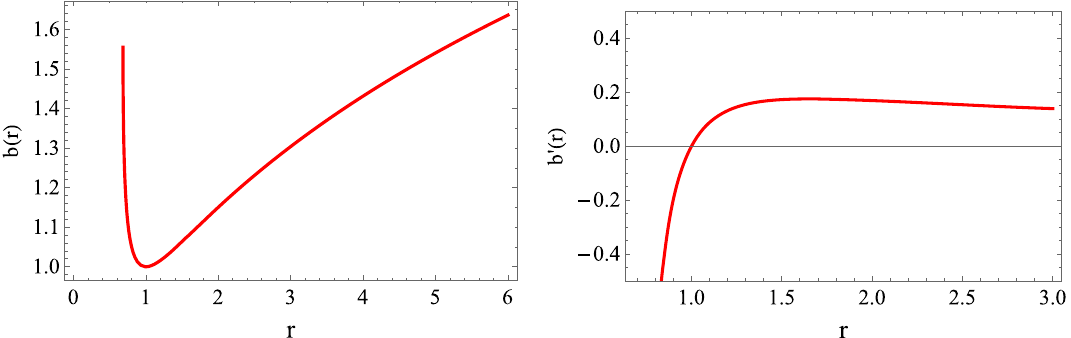
Fig. 2 Representation of b ( r ) and b (cid:7) ( r ) as a function of r for the anisotropic wormhole. The constants are α = 0 . 1 and r 0 = 1 along with ω = − 1 / 3 for left and right plots, respectively t